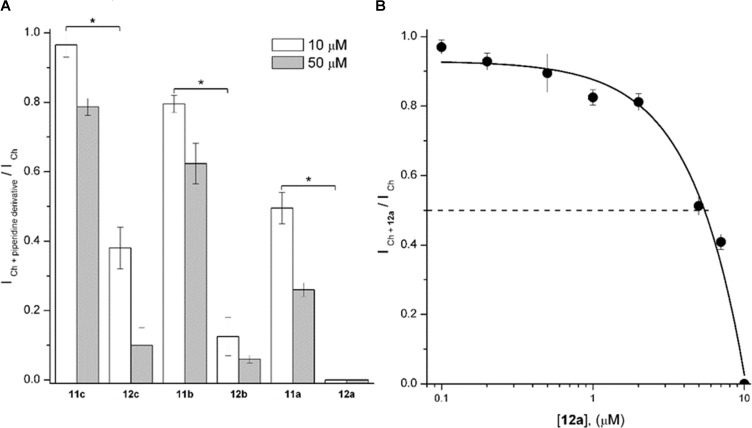
1-[2-(4-Alkyloxy-phenoxy-ethyl)]piperidine (11a-11c) and 1-[2-(4-alkyloxy-phenoxy-ethyl)]-1-methylpiperidinium iodides (12a-12c) inhibited rat hippocampal α7 nAChRs. (A) The height of the columns represents the ratio between the ICh in the presence of the piperidine derivative (ICh
+
piperidinederivative) and the control ICh at 10 (white) and 50 μM (gray columns) of each compound. Experiments were performed as described in Section “Materials and Methods.” Each column represents the mean ± standard error of at least three recorded interneurons. Unless otherwise stated, holding potential was –70 mV. Asterisks indicate significant statistical difference (p < 0.05) when compared methylated with non-methylated piperidine derivatives at 10 μM, performed by the Student’s t-test. (B) The 12a concentration/Ch-response relation in hippocampal CA1 interneurons. The ratio between the ICh in the presence of 12a (ICh
+
12a) and the control ICh is plotted as a function of 12a concentration. Each point is the mean ± standard error from n = 3–7 interneurons. Dashed line corresponds to 50% of the maximal control ICh.